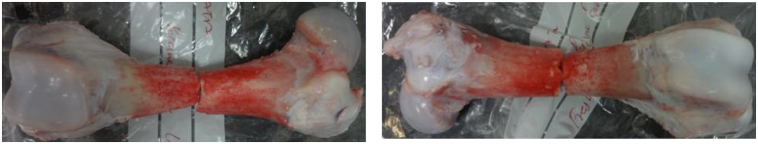
Two examples of fractures generated on femoral porcine bone.